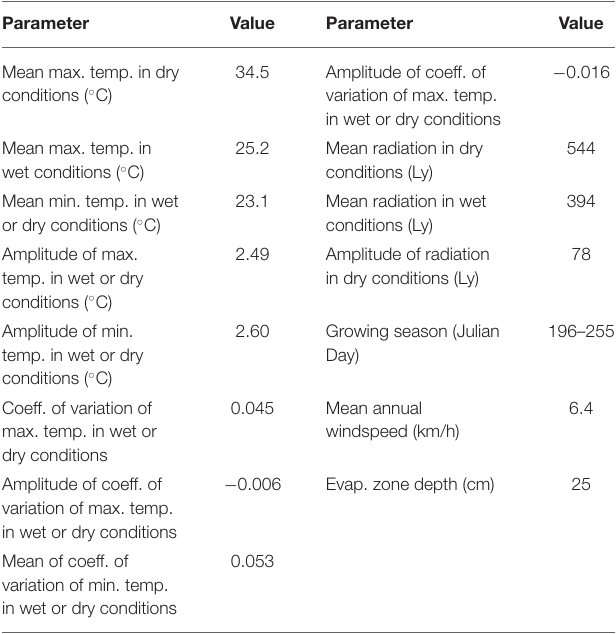
TABLE 3 | Additional default parameters for Bamako in the weather